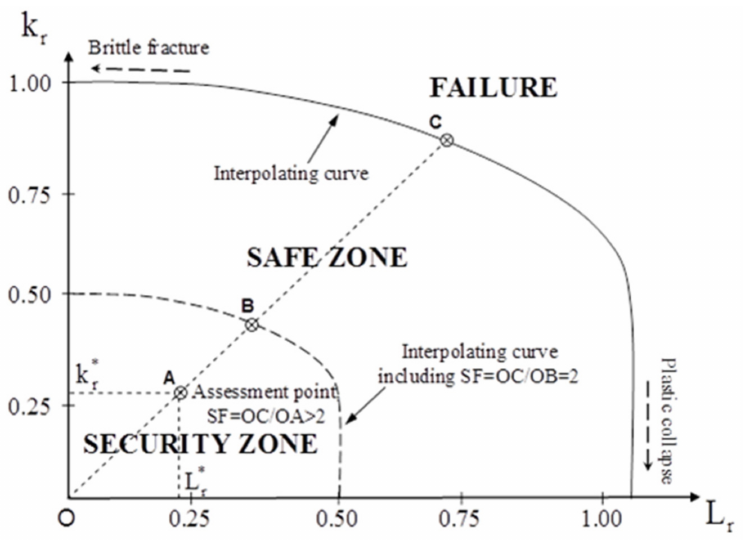
Figure 12. Failure Assessment Diagram